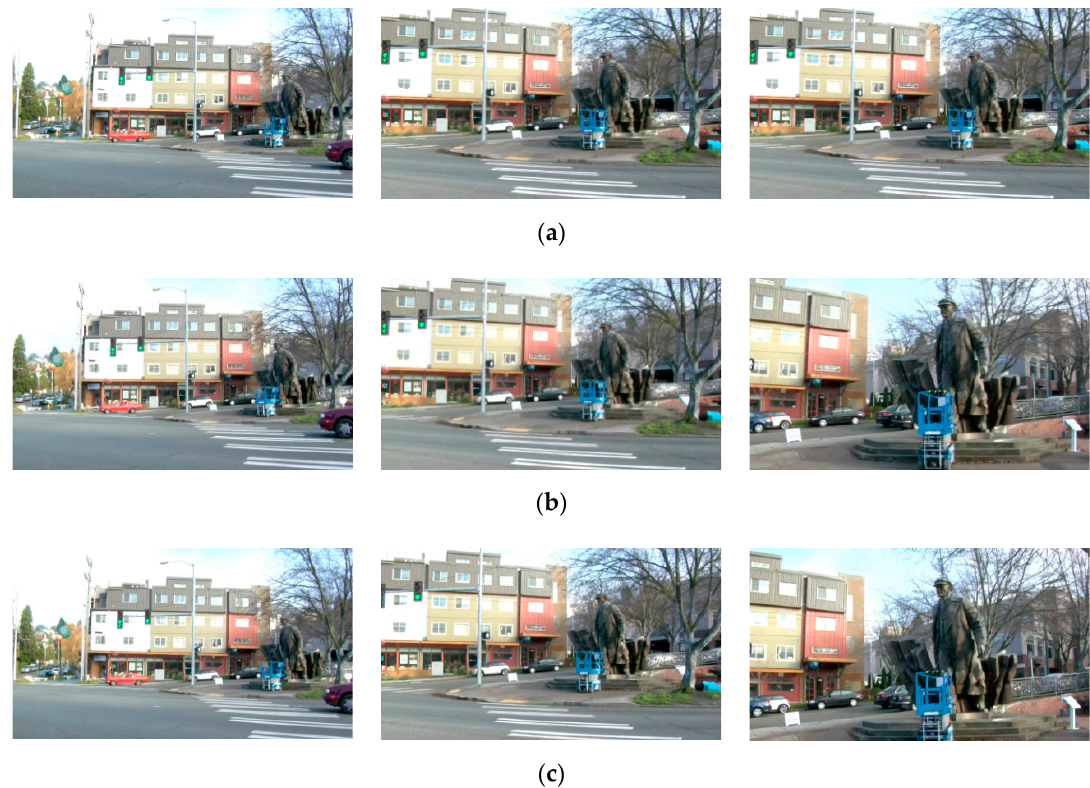
Figure 9. Video stabilization of 2WL video sequence. ( a ) Original frames (30th, 200th, and 430th frames); ( b ) Stabilized by Deshaker; ( c ) Stabilized by proposed method. Table 2. ITF values of image sequences (dB).